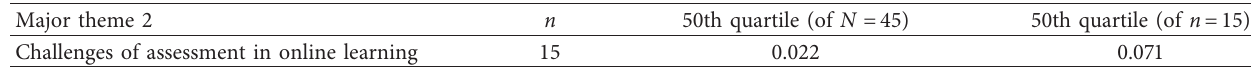
Table 14: 50th quartiles for challenges of assessment in online